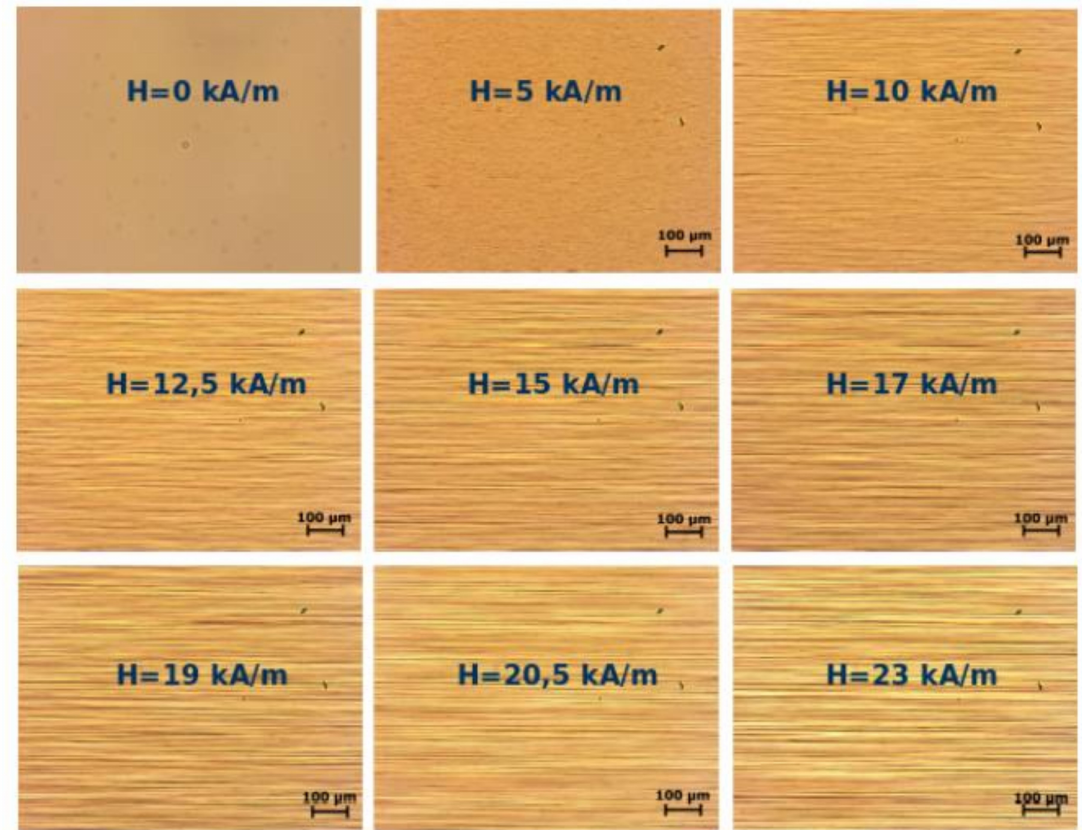
Figure 16. Microscopic images of the magnetic fluid based on multicore magnetite nanoparticle structures at various magnetic field strengths; the concentration of the magnetic phase was ϕ ≈ 0.013 vol.%